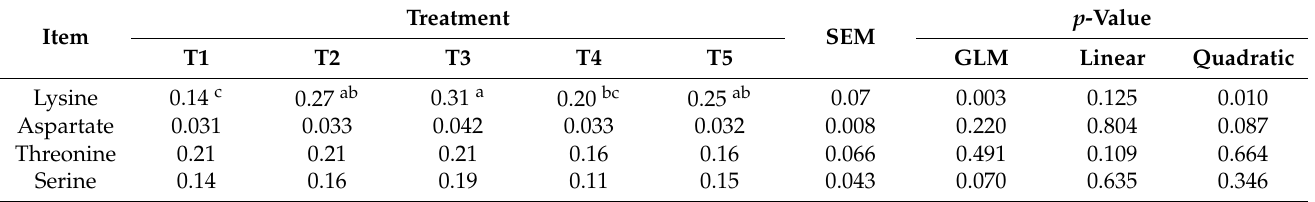
Table 6. Effect of dietary SID lysine levels on the concentration of free amino acids in serum of Baqing pigs at 20–90 kg